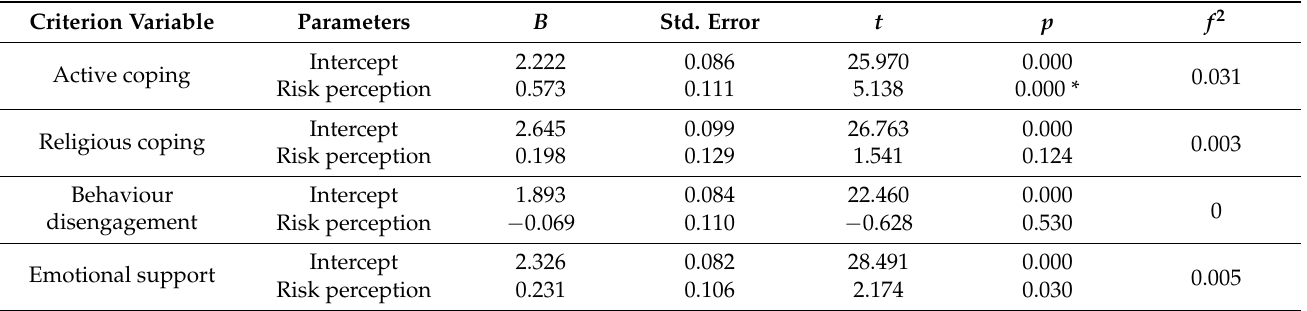
Table 2. Regression parameters for the relationship between COVID-19 risk perception and coping